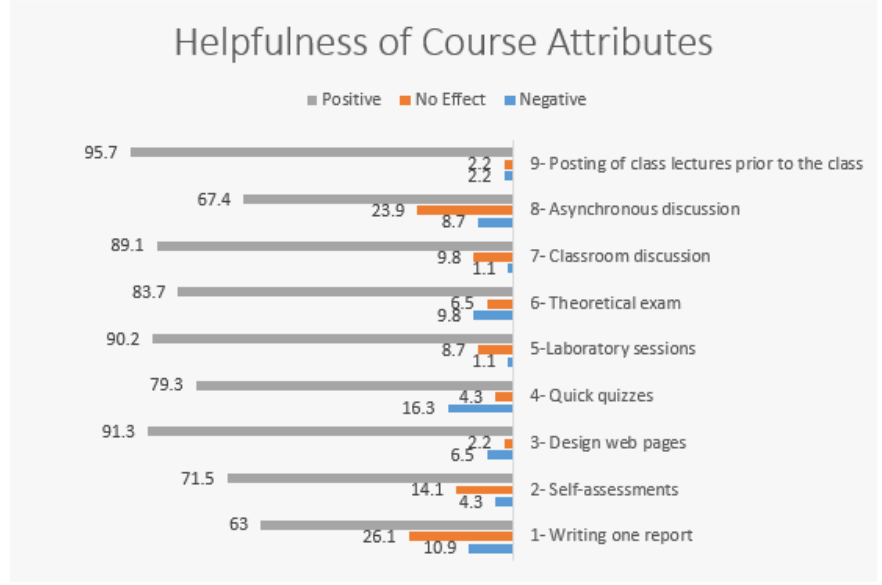
Figure 8. The helpfulness of the course attributes